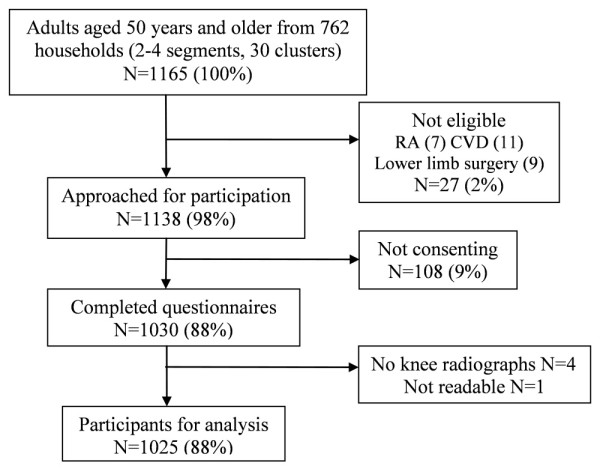
Wuchuan County Osteoarthritis Study. Recruitment.